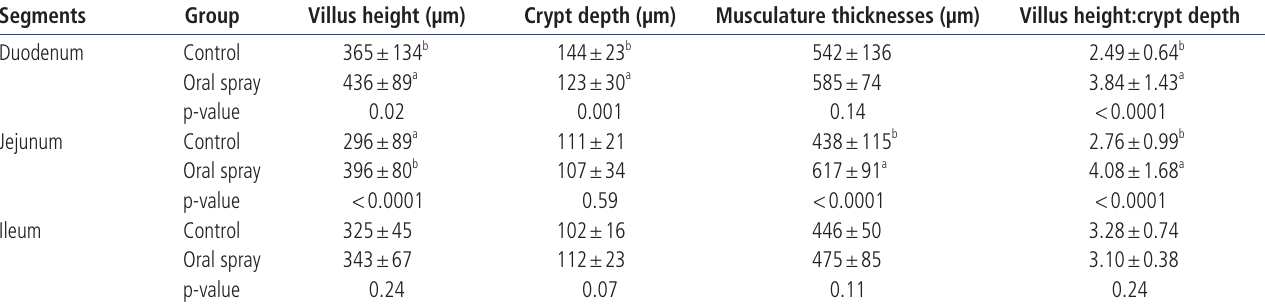
Table 6. Effect of oral spray with Lactobacillus on intestinal histomorphology of ducklings at 21 d of age